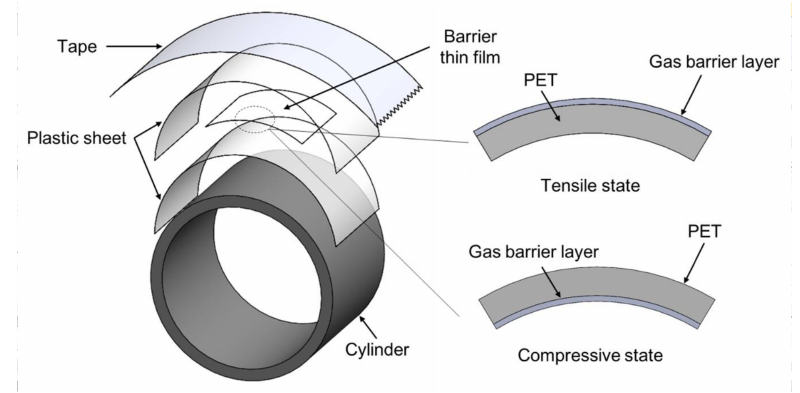
Figure 2. Schematic diagram of static bending test and